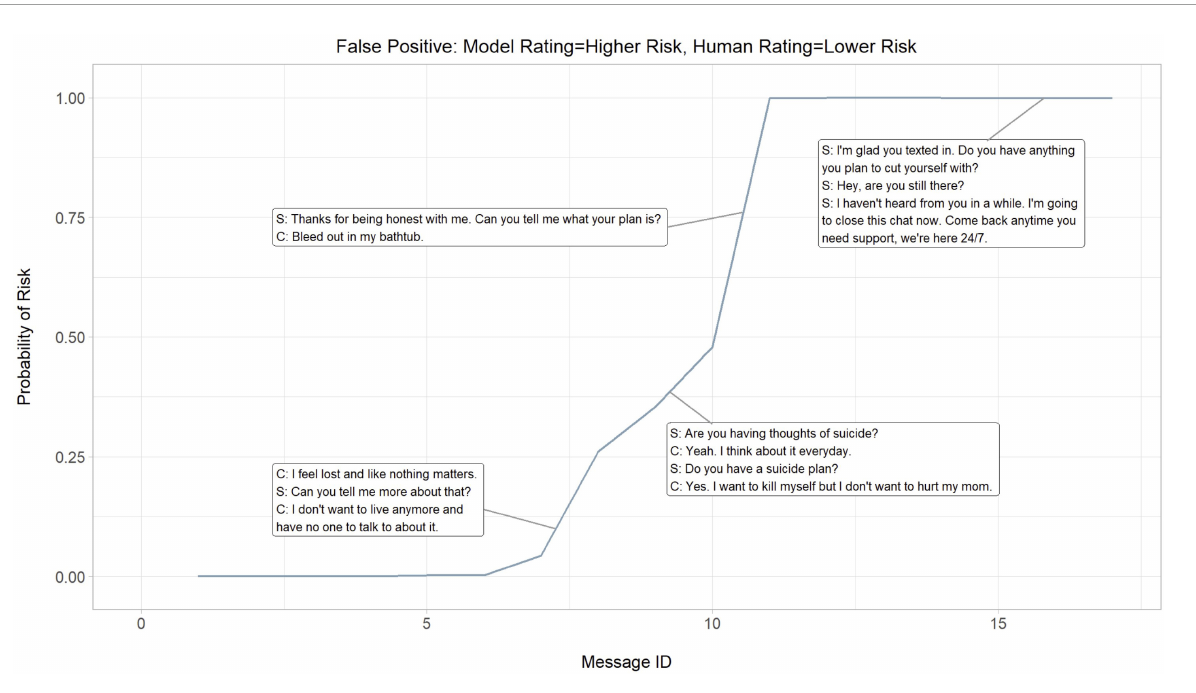
FIGURE4 Dialogue risk curves: Model rating = higher risk, Human rating = higher risk (False positive). S, SafeUT counselor; C, SafeUT client. Crisis counseling encounter has been fictionalized to maintain